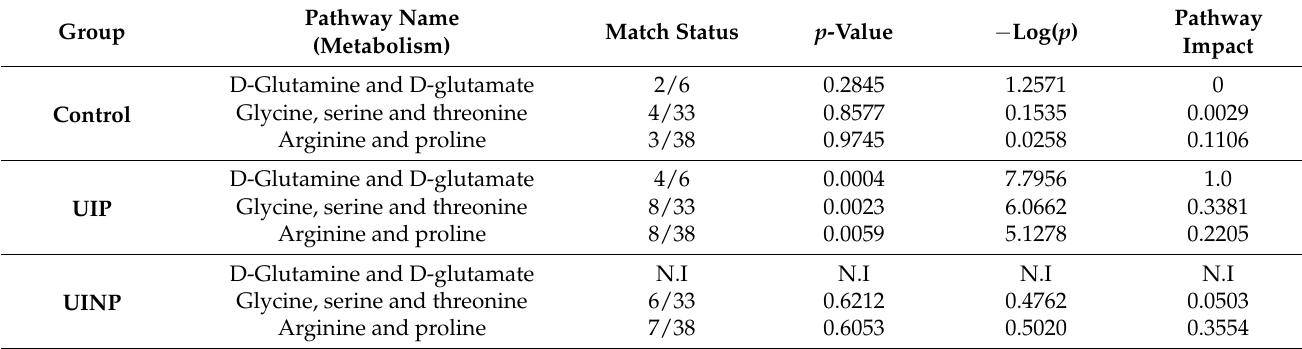
Table 2. Statistical overview of metabolic pathways associated with FMP